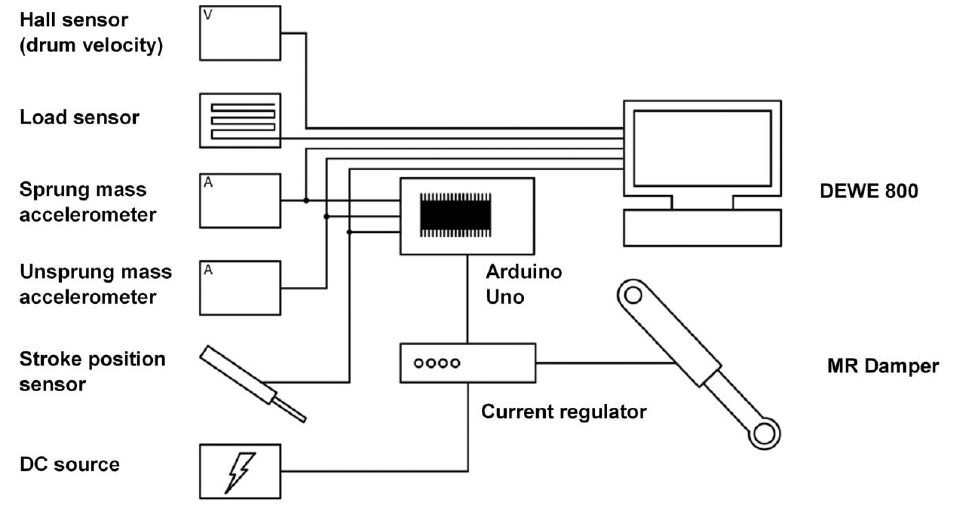
Figure 3. Control system.